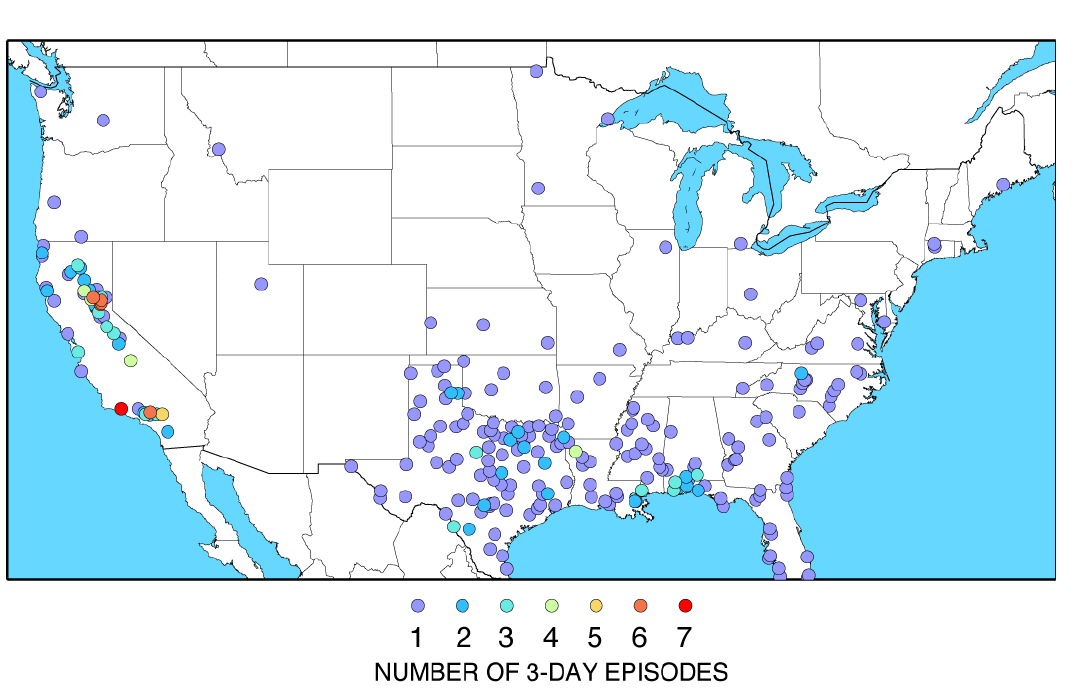
Figure 4. Numbers of reported occasions of (nonoverlapping) 3-day precipitation totals at cooperative weather stations that exceeded 40 cm, from